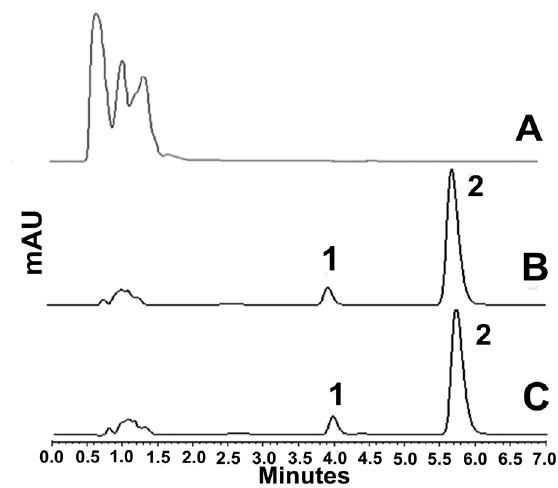
FIGURE 3 - Chromatograms of placebo solution (A), standard solution at 5.00 µg.mL -1 of ethinyl estradiol (1) and 750.00 µg.mL -1 of drospirenone (2) (B), and sample solution 5.00 µg.mL -1 of ethinyl estradiol (1) and 750.00 µg.mL -1 of drospirenone (2) (C).Chromatographic conditions: LiChroCART ® column (125 mm x 4 mm i.d., 5 µm particle size), mobile phase: acetonitrile:water (50:50 v/v), flow rate: 1.0 mL.min -1 , injection volume: 20 µL, temperature: 25 ± 1 °C. UV detection at 200